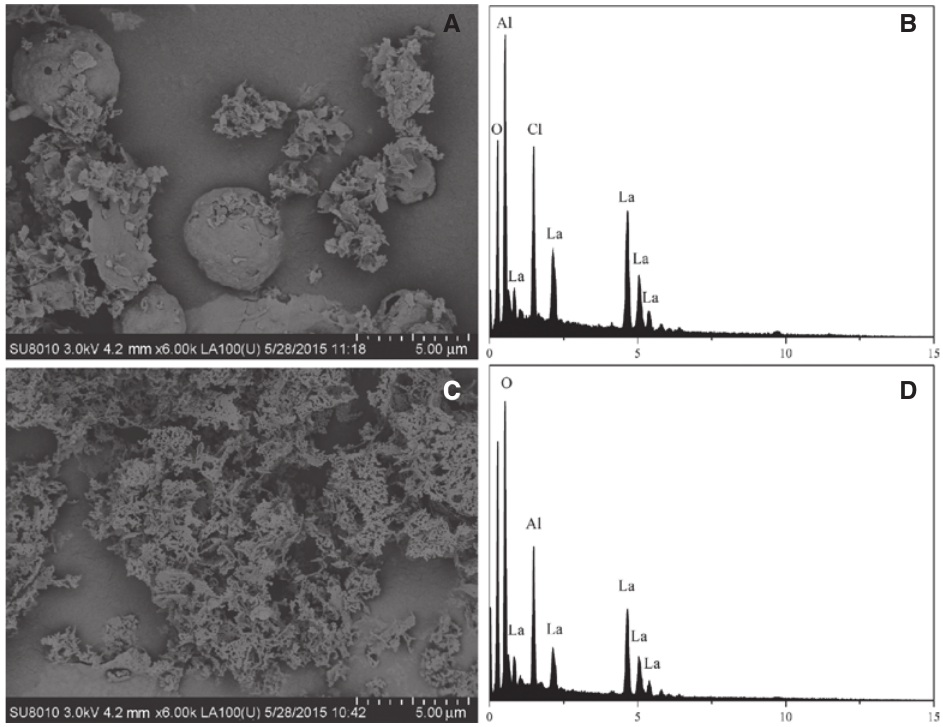
Figure 6: SEM images and EDS patterns of the Al